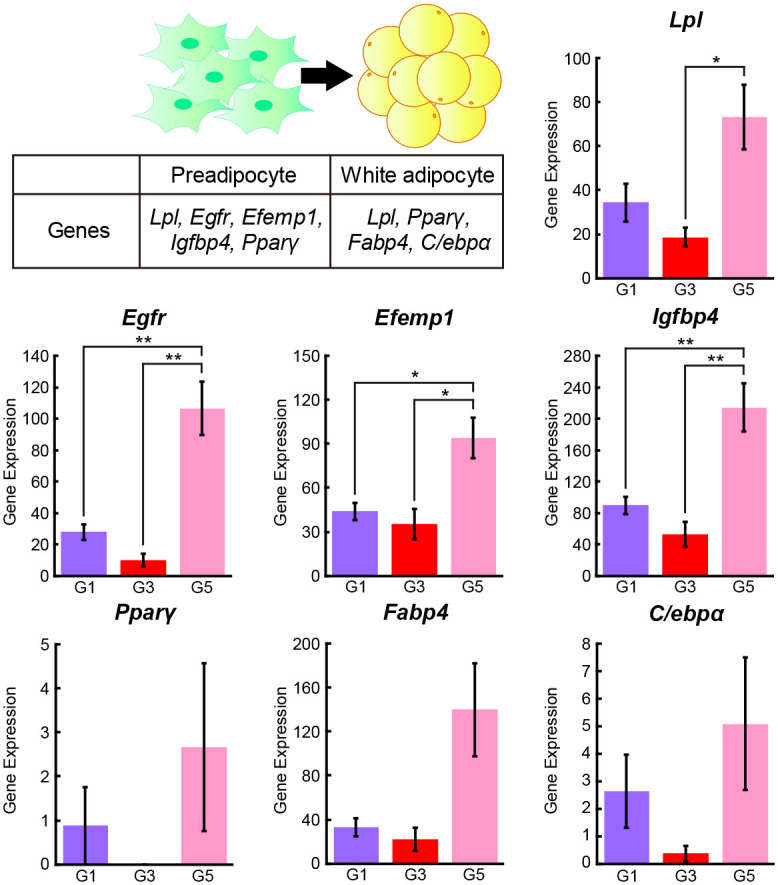
Preadipocyte and white adipocyte marker gene expression among Groups 1, 3, and 5.The gene expression levels of Lpl, Egfr, Efemp1, Igfbp4, Pparγ, Fabp4, and C/ebpα in Groups 1 (purple), 3 (red), and 5 (magenta) are shown. G1: Group 1 (cell number, n = 191), G3: Group 3 (cell number, n = 136), G5: Group 5 (cell number, n = 134). Values are presented as the means ± SEMs. The statistical analysis was performed using one-way analysis of variance followed by the Tukey-Kramer test. *p<0.05, **p<0.01.